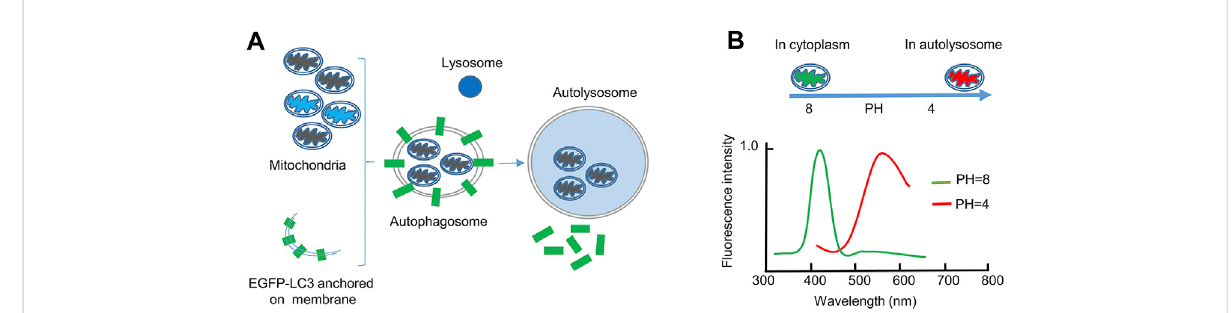
FIGURE 1 The EGFP-LC3 and mt-Keima systems for monitoring mitophagy. (A) , The EGFP-LC3 system. In this system, the autophagosomal marker protein LC3 is fused with EGFP. When mitochondria are dysfunctional (black), they will be engulfed by a double-membrane autophagosome for degradation.EGFP-LC3isanchoredonboththeinnerandoutermembranesofautophagosomes.WhenmitochondriaarestainedwithMito-Tracker Red, colocalization of the two fl uorescent signals indicates mitophagy. After the autophagosome fuses with the lysosome, the EGFP signal will disappear, because the EGFP-LC3 returns to the cytoplasm or is degraded by lysosomal proteases. (B) , The mt-Keima system. In this system, the fl uorescentproteinKeima,derivedfromcoral,isfusedwithamitochondrialmatrixprotein.Theexcitationwavelengthofmt-KeimaissensitivetopH. At neutral pH, the excitation wavelength of mt-Keima is 440 nm; therefore, it can be detected by 458 excitation laser. At acidic pH, the excitation wavelength of mt-Keima is 586 nm; therefore, it can be detected by 561 excitation laser. The lysosomal lumen is an acidic environment, and therefore mitochondria engulfed in autolysosomes can be monitored by 561 excitation